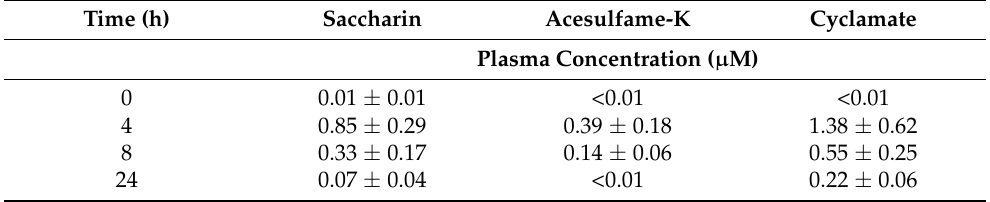
Table 1. Plasma concentrations of sweeteners in healthy volunteers at different intervention